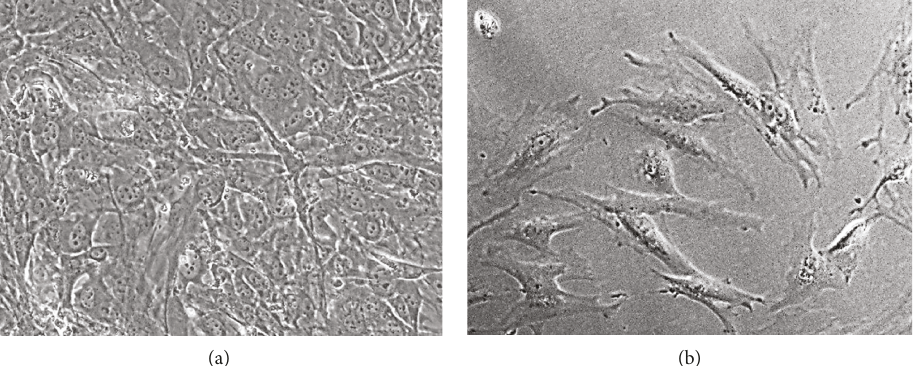
Figure 3: Mesenchymal stem cells in culture under phase-contrast microcopy. (a) Bone marrow-derived MSC. (b) Adipose tissue-derived MSC. Original magni fi cation 200x. Table 1: Di ff erences in cell membrane CD expression and di ff erentiation capacity between BM-MSC and AD-MSC. Data from [60 – 62]. Surface